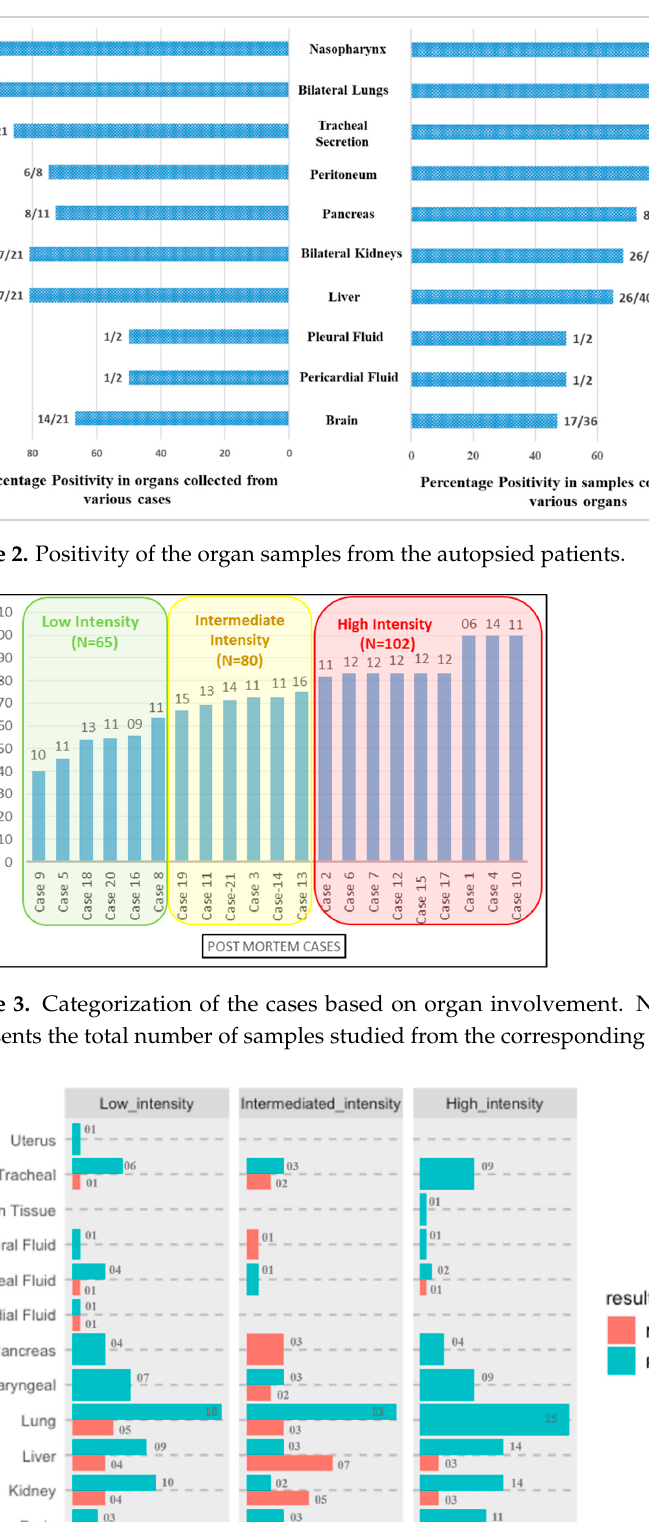
Figure 2. Positivity of the organ samples from the autopsied patients.